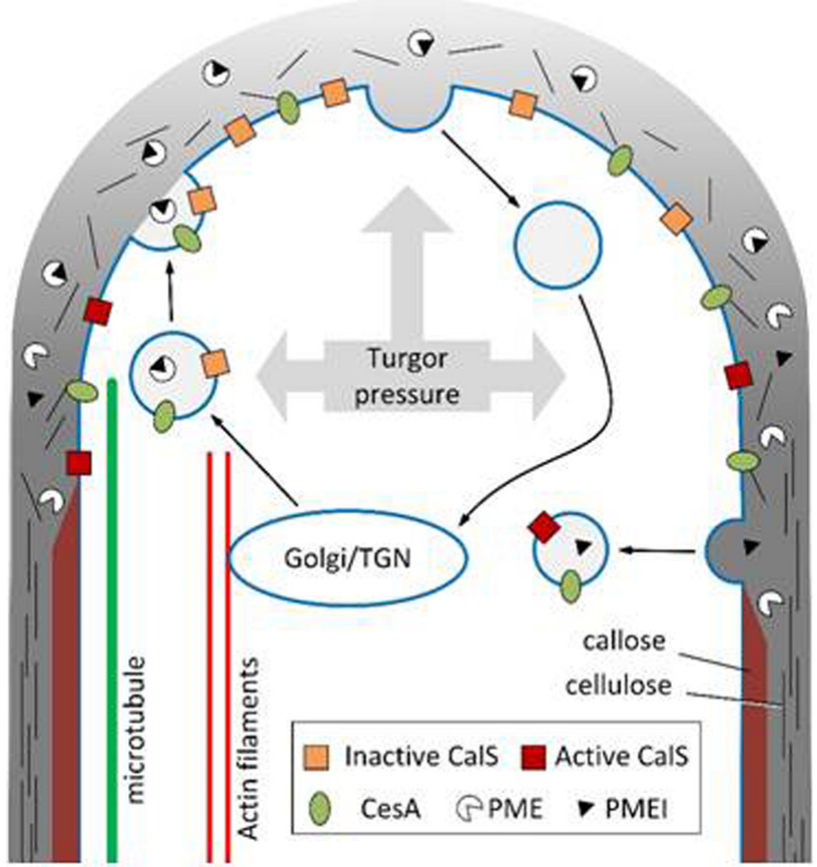
Figure 6. Schematic diagram of the secretion process in pollen tubes. Only the key elements involved in cell wall synthesis are shown (PME, PMEI, CESA, CALS). The gradient of gray in the cell wall indicates the status of methyl-esterification of pectins (light gray: fully methyl-esterified pectins; dark gray: acid pectins). Cellulose is shown as random black lines in the tube apex and as more organized lines in distal parts. Callose is shown as red bands in the pollen tube shanks. TGN, Trans-Golgi-Network. Actin filaments (red lines) are shown as interacting with the Golgi, indicating that they are involved in the transport of vesicles to the apex. Microtubules (green lines) are shown as positioned in the cortical region where they presumably could interact with CALS and CESA. Secretion is indicated to occur not exactly at the apex but in a region immediately close. Endocytotic processes are hypothesized to occur both at the extreme apex and in more distal regions